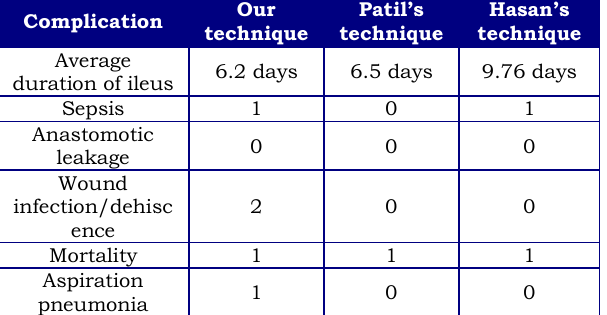
Table 1: Distribution of postoperative